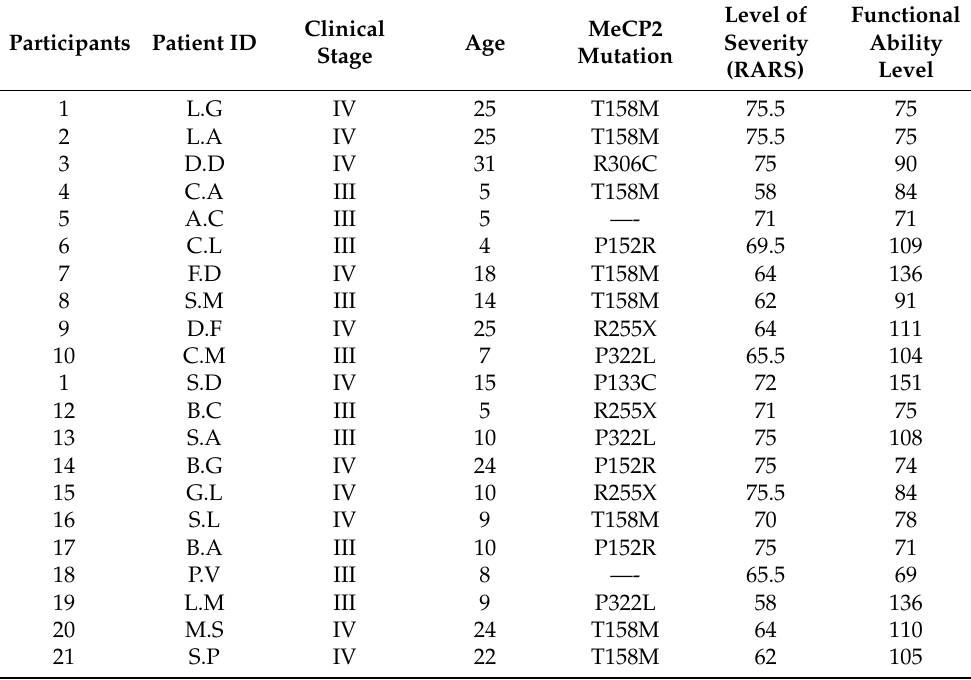
Table 1. Characteristics of participants (this table comes from work Fabio et al.